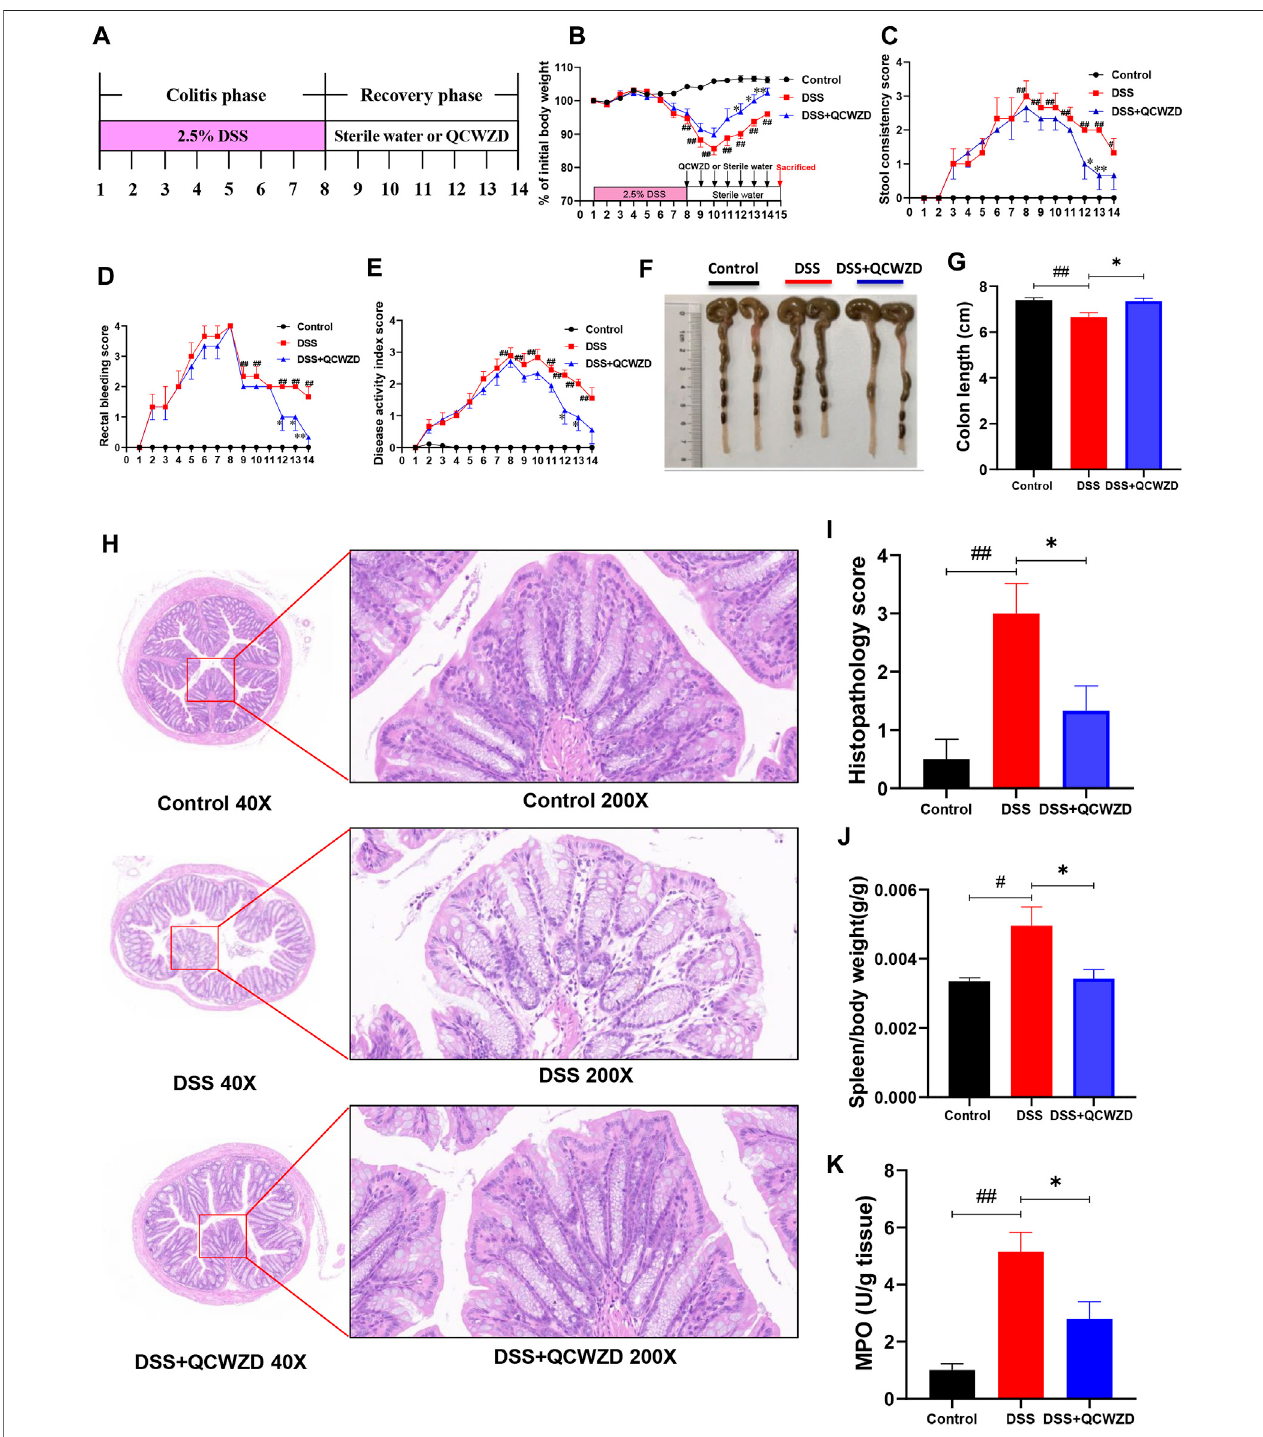
FIGURE1| AdministrationofQCWZDSigni fi cantlyAcceleratesIntestinalMucosalHealingafterDSSDamage.Miceweregiven2.5%DSS(w/v)indrinkingwaterfor 7 days followed by one week treatment of QCWZD at a dose of 1.8 g/kg or sterile water, then the clinical phenotypes and the severity of colitis were assessed. (A) Experimental design, (B) Body weight, (C) Rectal bleeding, (D) Stool consistency, (E) Disease activity index (DAI) score, (F, G) Colon and colonic length, (H, I) Hematoxylinandeosin(H&E)stainingofthecolonandHistologicalscore. (K) MPOactivity.Thedatashownarethemean ± theSEM( n (cid:2) 4 – 6mice/group)fromone of three experiments performed showing similar results. ## p < 0.01, # p < 0.05 versus the Control group; pp p < 0.01, p p < 0.05 versus the DSS group. Signi fi cance was determined by one-way ANOVA test (Tukey ’ s multiple comparison test).